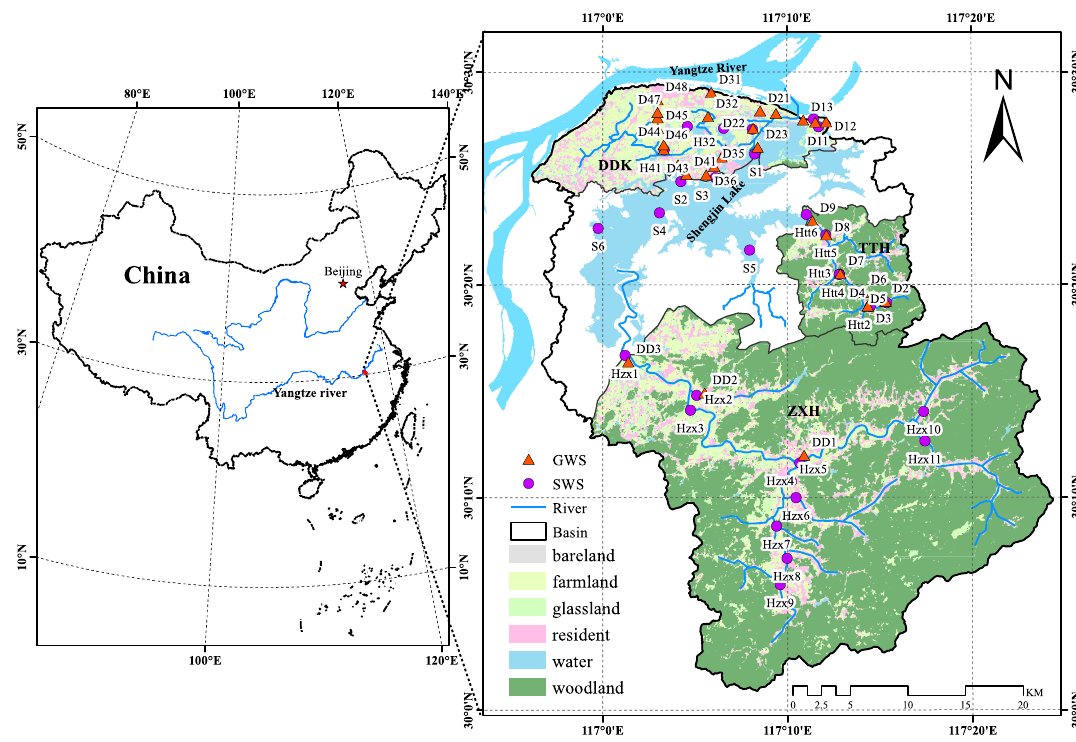
Figure 5. Distribution of three watersheds and water-sampling sites in Shengjin Lake